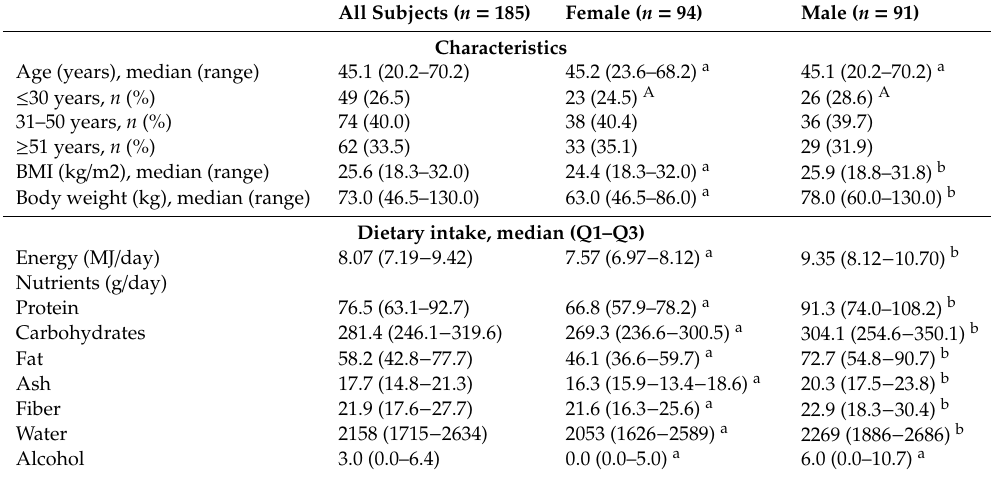
Table 1. Characteristics of the study population and dietary